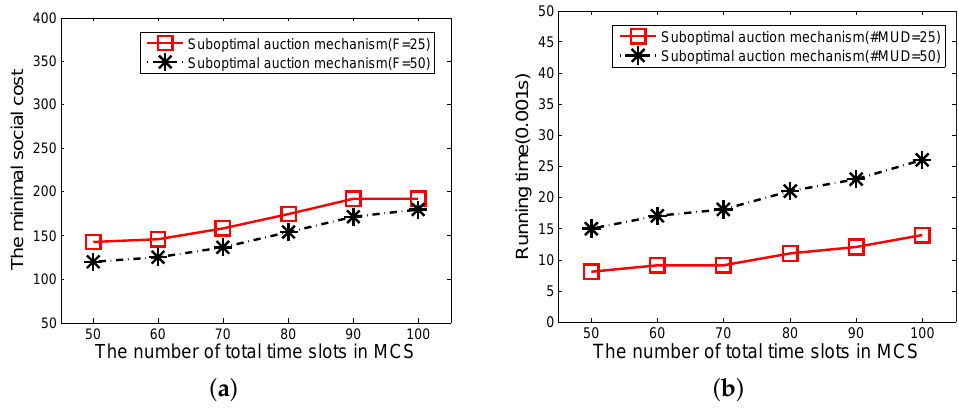
Figure 6. ( a ) The social cost of suboptimal auction mechanism in discontinuous working pattern; ( b ) The running time of suboptimal auction mechanism in discontinuous working